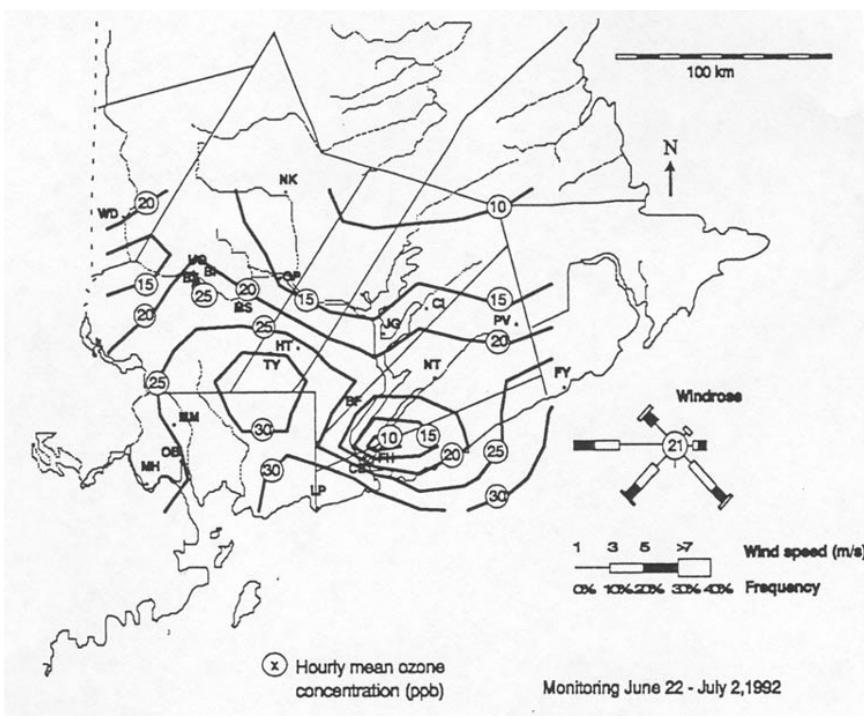
FIGURE 6. Contour map of ozone exposure measured with CanOxy Plate passive samplers in the canopy of white ash and black cherry in central and southern New Brunswick with major wind vectors from the southwest.